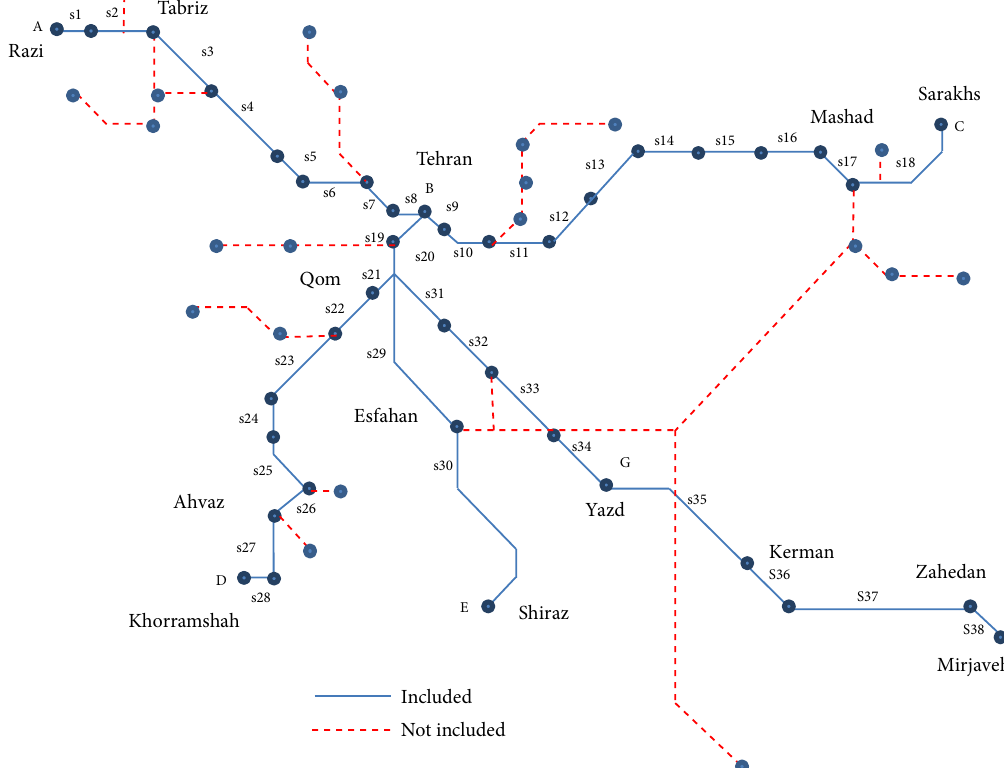
Fig. 1. Network diagram for the RAI